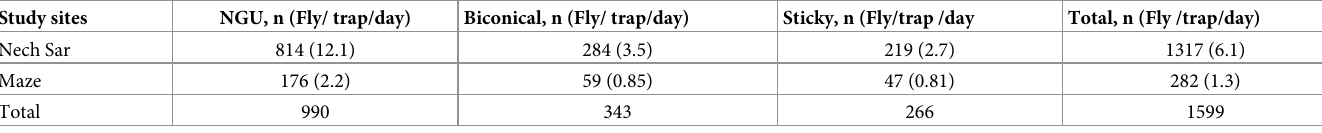
Table 1. Mean density of tsetse flies in Nech Sar and Maze National Parks, Southwest Ethiopia. Study sites NGU, n (Fly/ trap/day) Biconical, n (Fly/ trap/day) Sticky, n (Fly/trap